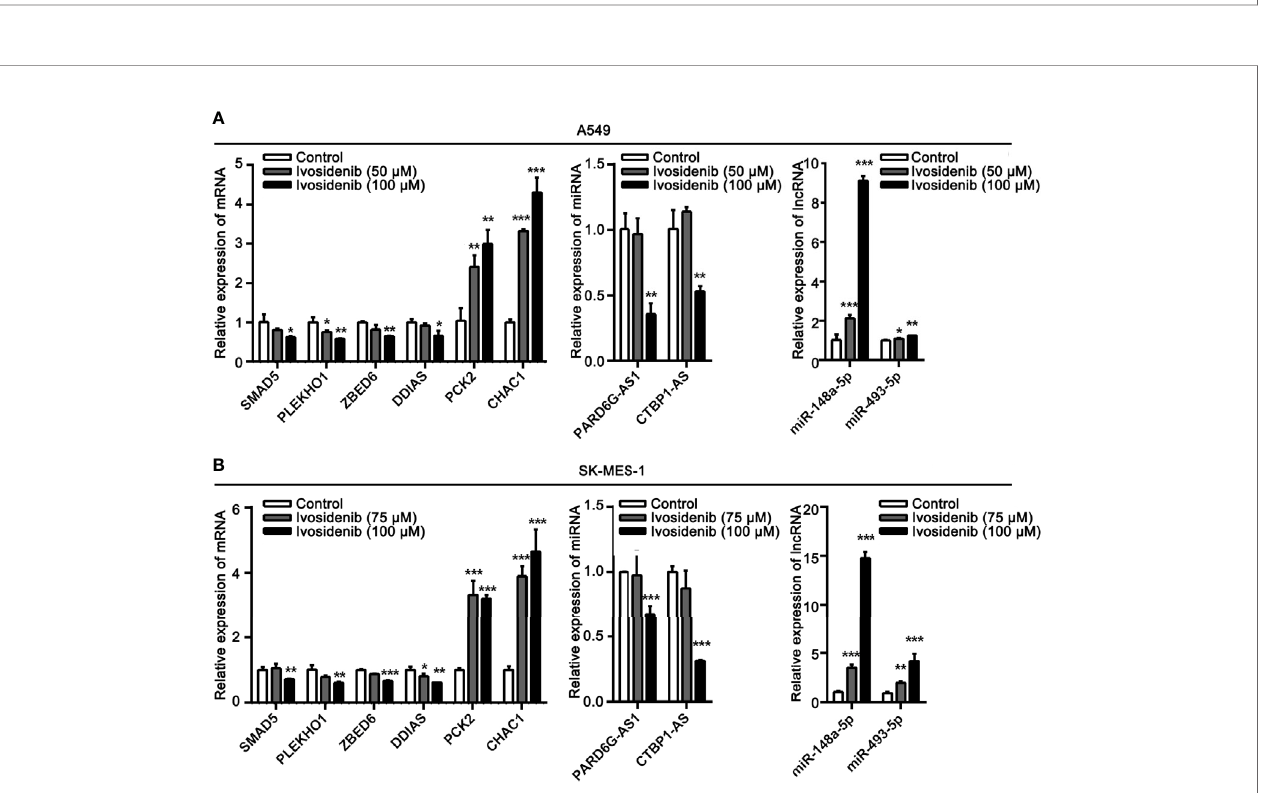
FIGURE 10 | QRT-PCR analysis of the expressions of DE-RNAs. (A) After treating with ivosidenib for 24 h, DE-RNAs expression was determined using RT-qPCR in A549 cells. (B) After treating with ivosidenib for 24 h, DE-RNAs expression was determined using RT-qPCR in SK-MES-1 cells. * p < 0.05, ** p < 0.01, and *** p < 0.001.